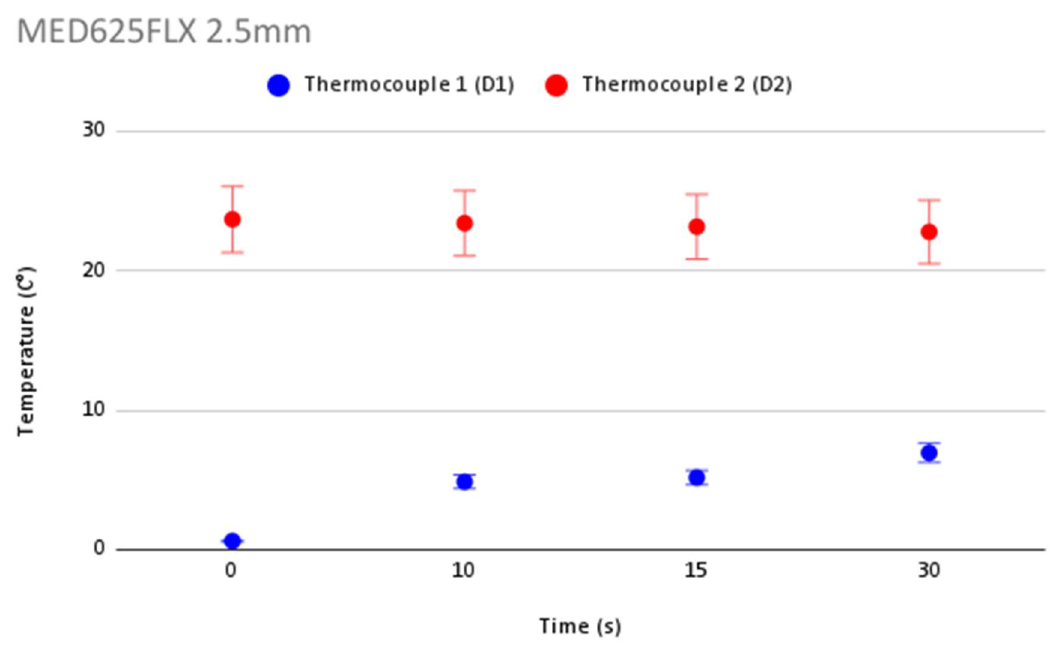
Figure 7. Repeatability of temperature measurements and error bars for MED625FLX of 2.5 mm.